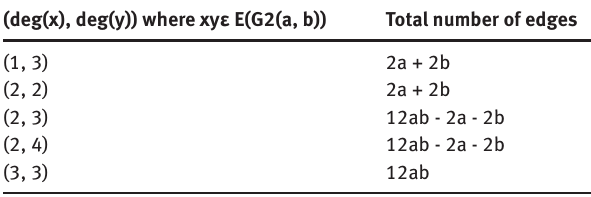
Table 2: Edge partition of 2 × 2 supercell of 2D CoBHT(CO)